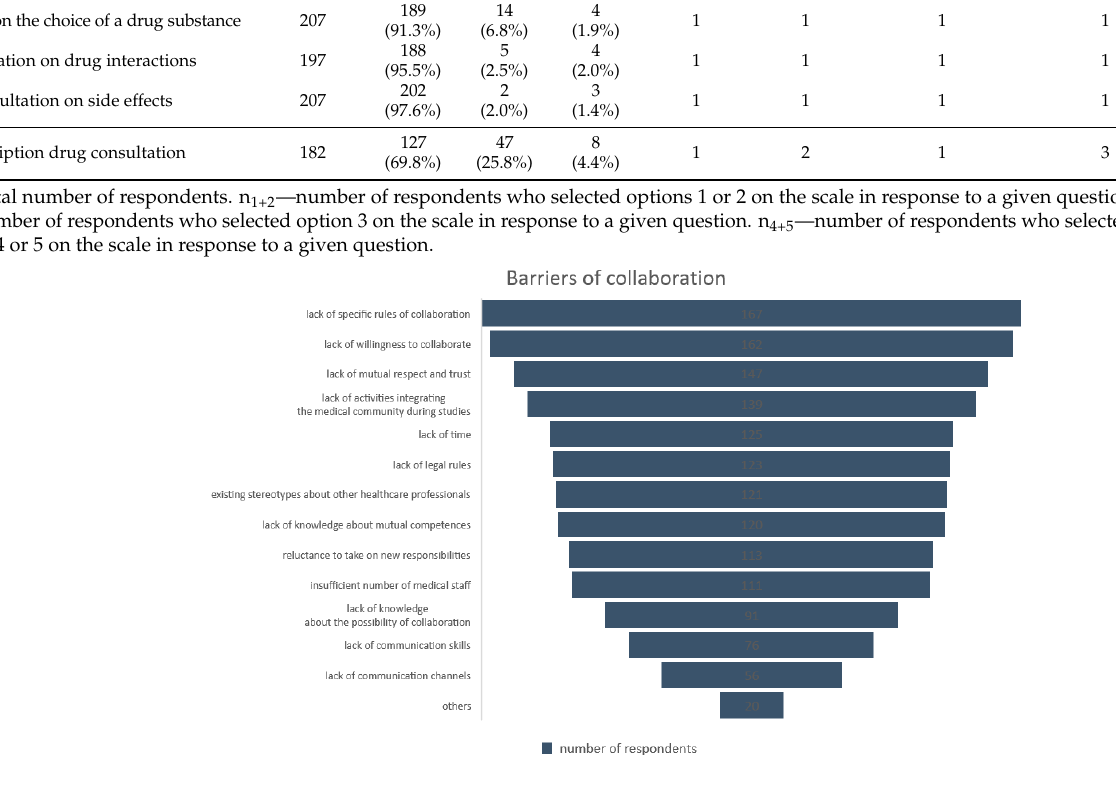
Figure 1. Barriers of collaboration.